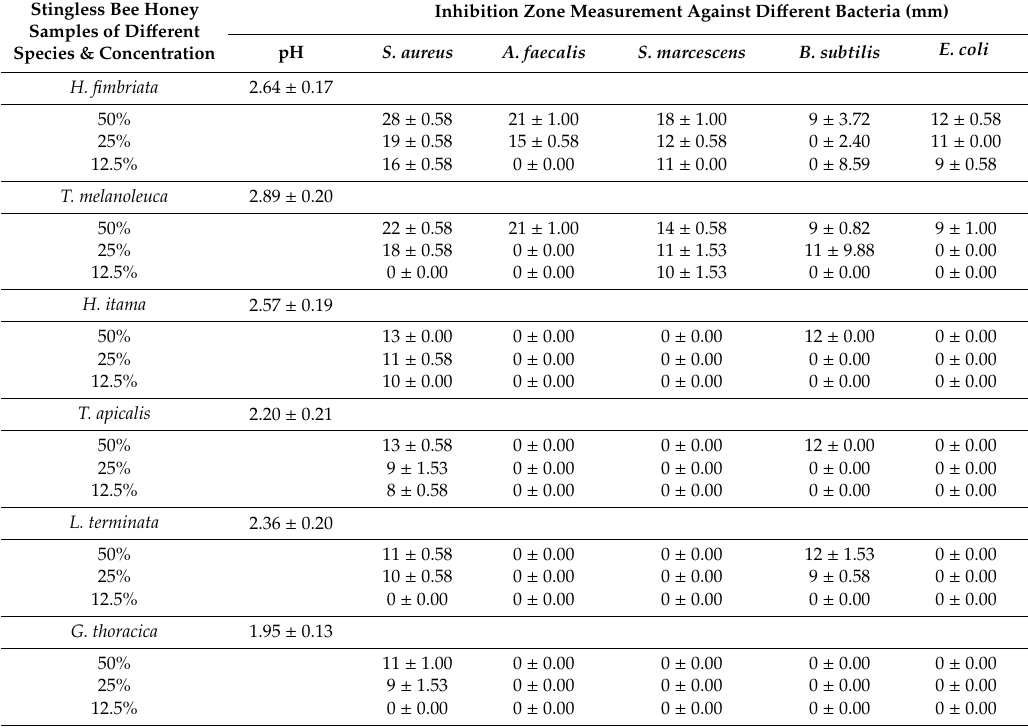
Table 1. Antimicrobial activity of stingless bee honey against five di ff erent bacteria and pH value. Stingless Bee Honey Samples of Di ff